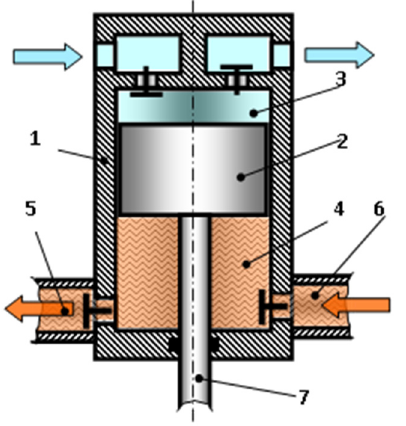
Figure 1. Construction diagram of piston hybrid power machine (PHPM). (1—cylinder; 2—piston;